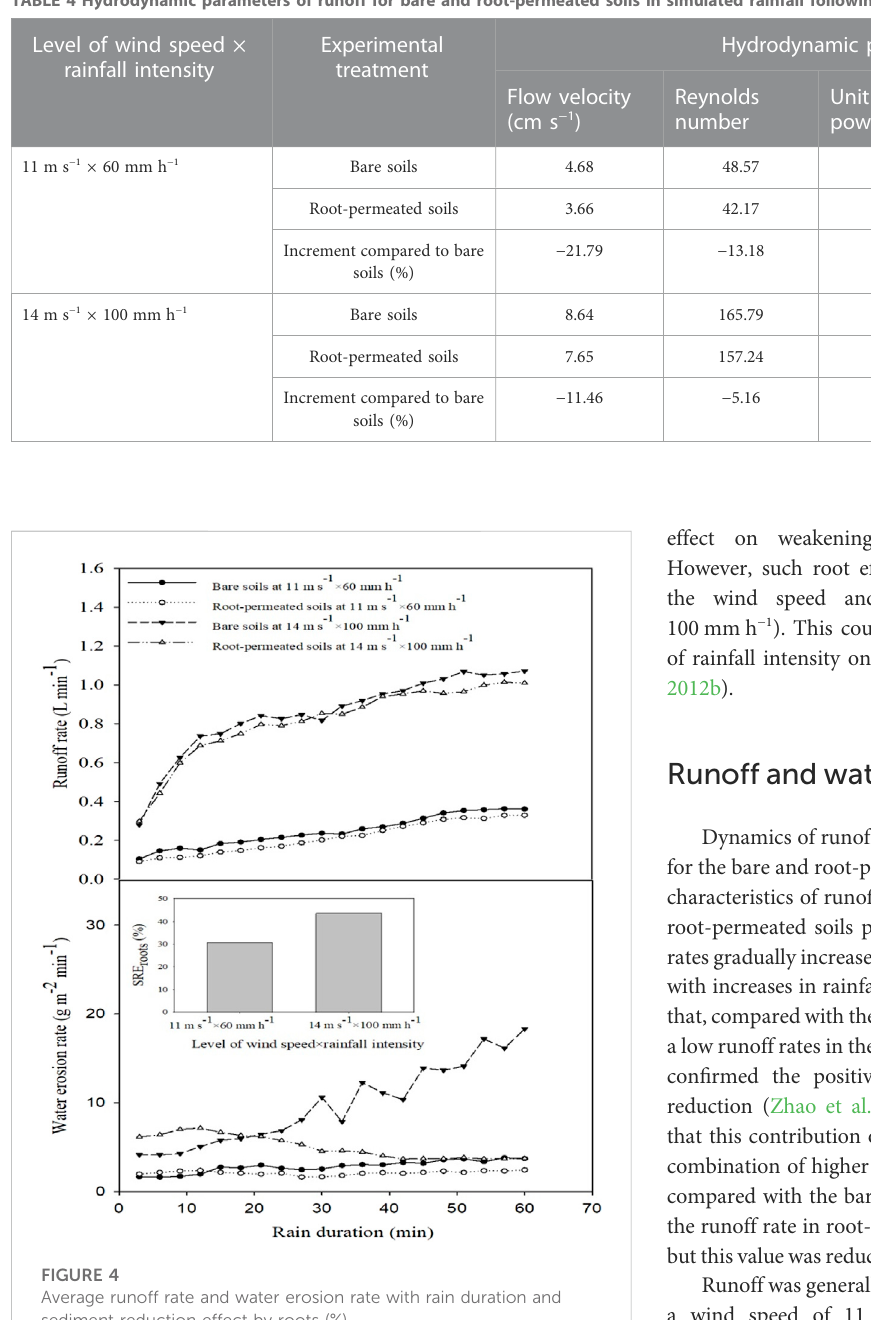
Average runoff rate and water erosion rate with rain duration and sediment reduction effect by roots